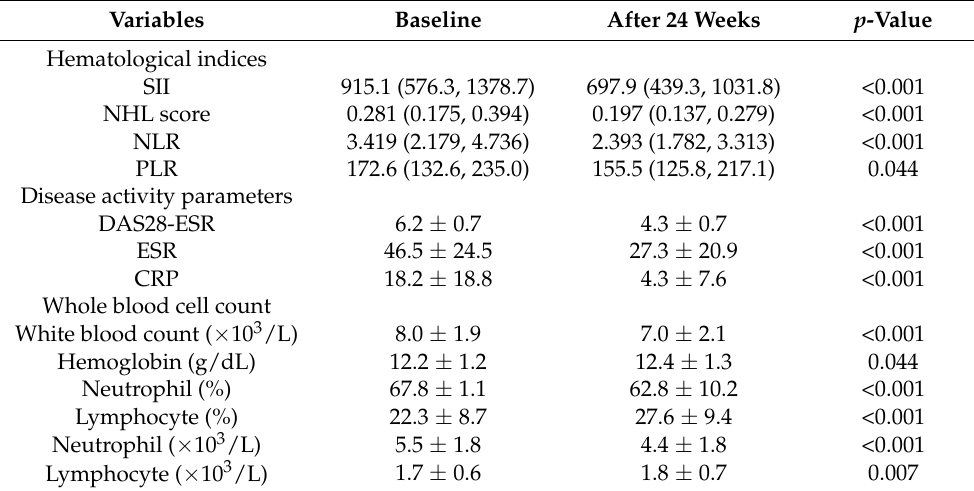
Table 4. Comparison of changes in disease activity markers before and after use of JAK inhibitor treatment ( n =